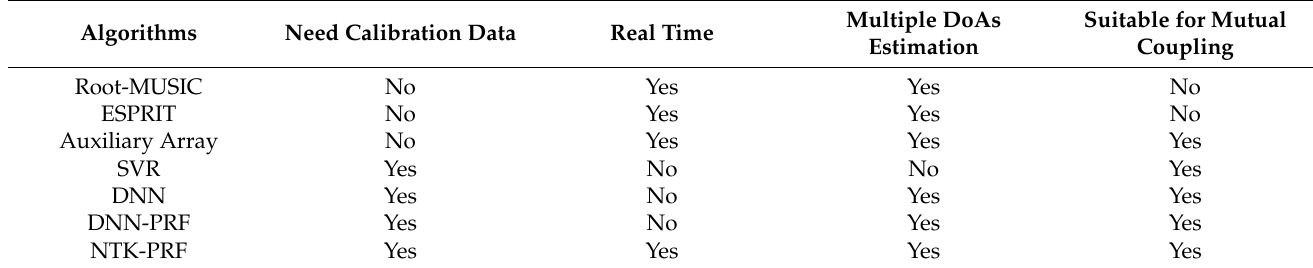
Table 2. Main distinctive characteristics between different methods.